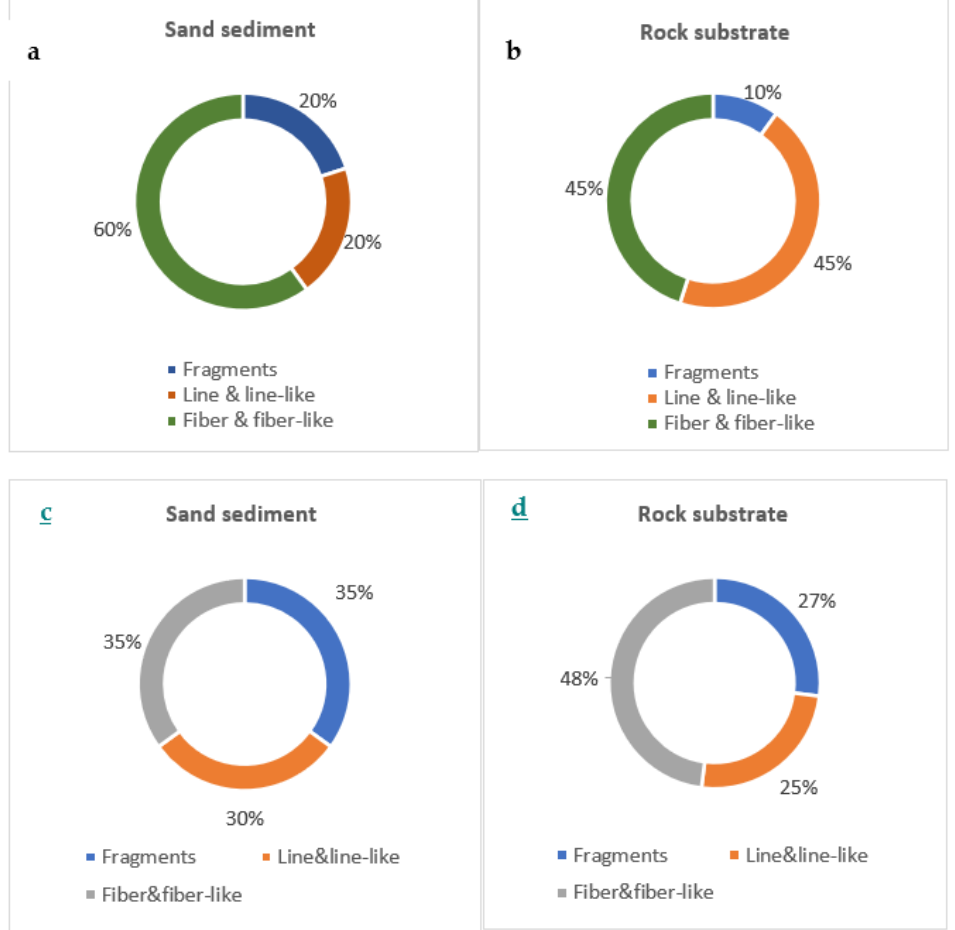
Figure 4. Percentage of MPs observed in sediment samples and in rock substrates in impacted stations ( a , b ) and in the control stations ( c , d ).